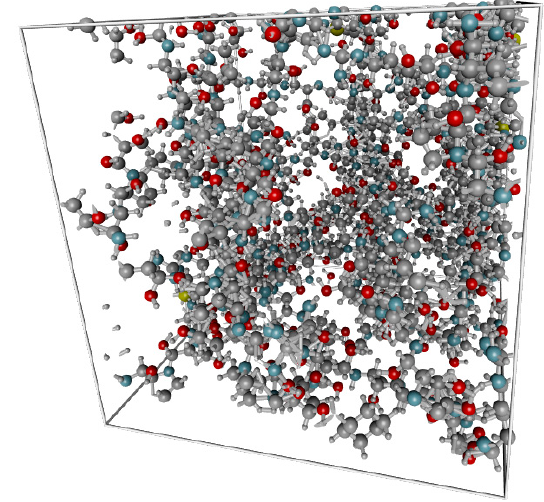
Figure 2. Gelatin model in cubic periodic boundary box of the size 31.89 Å (3462 atoms). The carbon atoms are colored in grey, oxygen in red, nitrogen in blue and hydrogen in white.